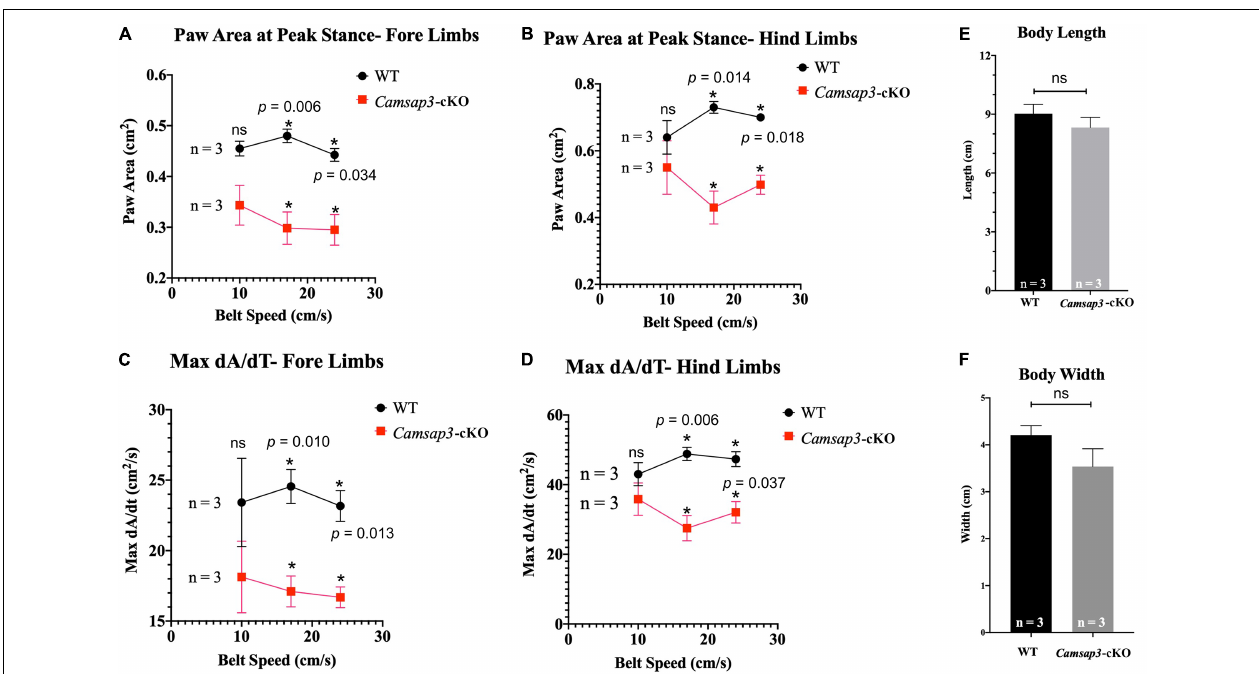
FIGURE 5 | Gait differences between WT and Camsap3 -cKO mice. Two litters of mice, ages P130–P133, were tested using the DigiGait Imaging System. Multiple t -tests revealed that Paw Area (A,B) and Max dA/dt (C,D) were significantly different between WT and Camsap3 -cKO mice ( p -values for each speed were as indicated). Bars represent mean ± SD. (E) Unpaired t -tests showed that there was no body length difference between male WT and Camsap3 -cKO mice (ns, p = 0.1572). (F) Unpaired t -tests showed that there was also no body width difference between male WT and Camsap3 -cKO mice (ns, p = 0.0539). N = 3 for both WT and Camsap3 -cKO mice. *Statistically significant